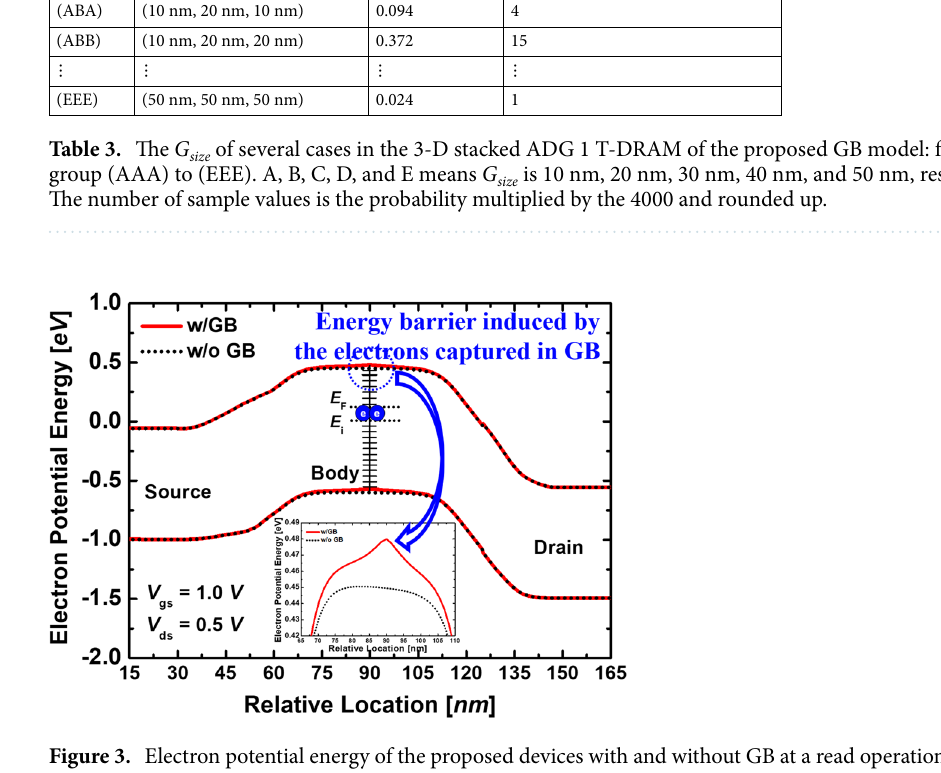
Fig. 4. In Fig. 5a, the averages of the extracted V th s of the single-layer ADG 1T-DRAMs and the 3-D stacked ADG 1T-DRAMs are 1.002 V and 0.956 V , respectively. The SDs for the V th s are 15.9 mV and 6.5 mV, respectively. The RSDs are 1.58% and 0.68%, respectively. The RSD is the SD divided by the mean and multiplied by 100. In other words, a large RSD indicates that the SD is large in comparison to the mean and it has a large dispersion. Since the RSD is expressed as a percentage, it is a coefficient of merit that can be used to compare the spread of data sets with different measurement units. The I d are higher in the 3-D stacked ADG 1T-DRAMs due to the multi-layer structure, resulting in lower V th . The RSDs of the V th s are 1.58% for the single-layer ADG 1T-DRAMs